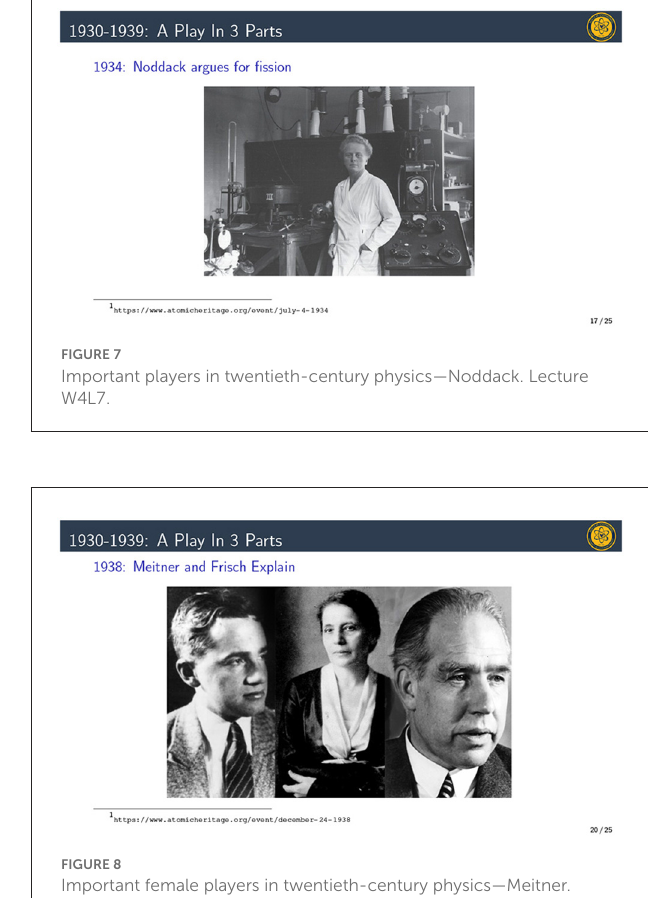
FIGURE6 Important female players in twentieth-century-century physics—Juliot-Curie. Lecture W4L7.